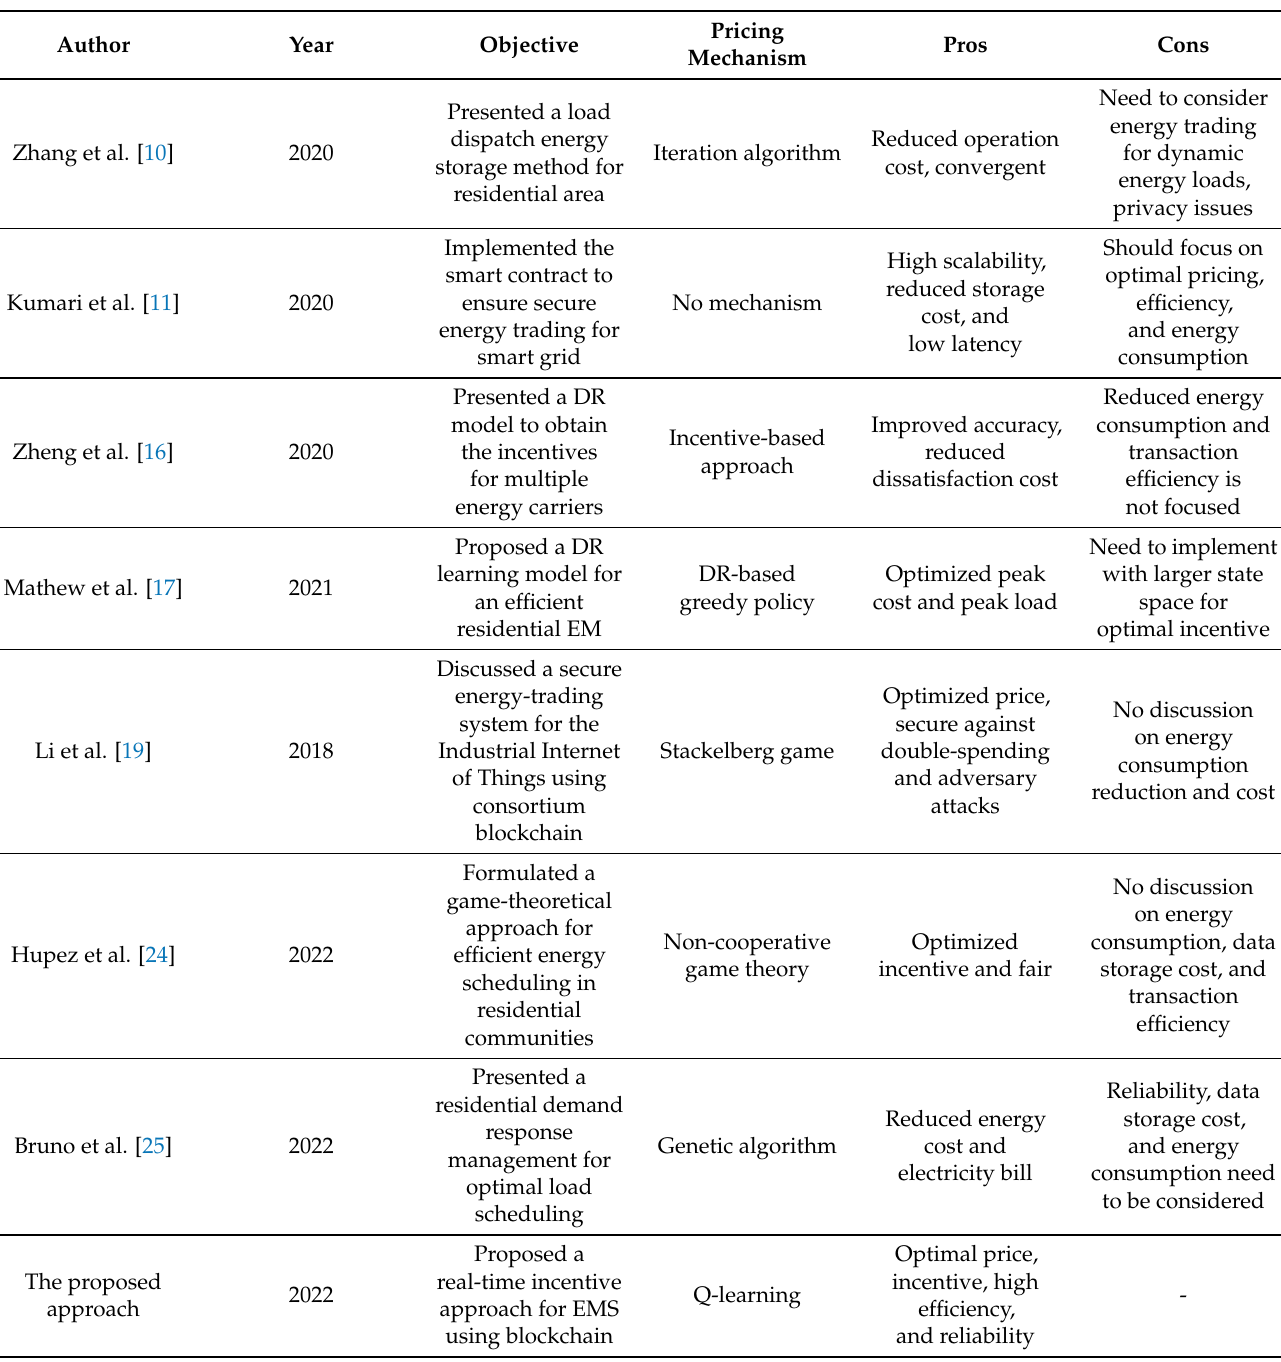
Table 1. Comparative analysis of various state-of-the-art EMSs with the